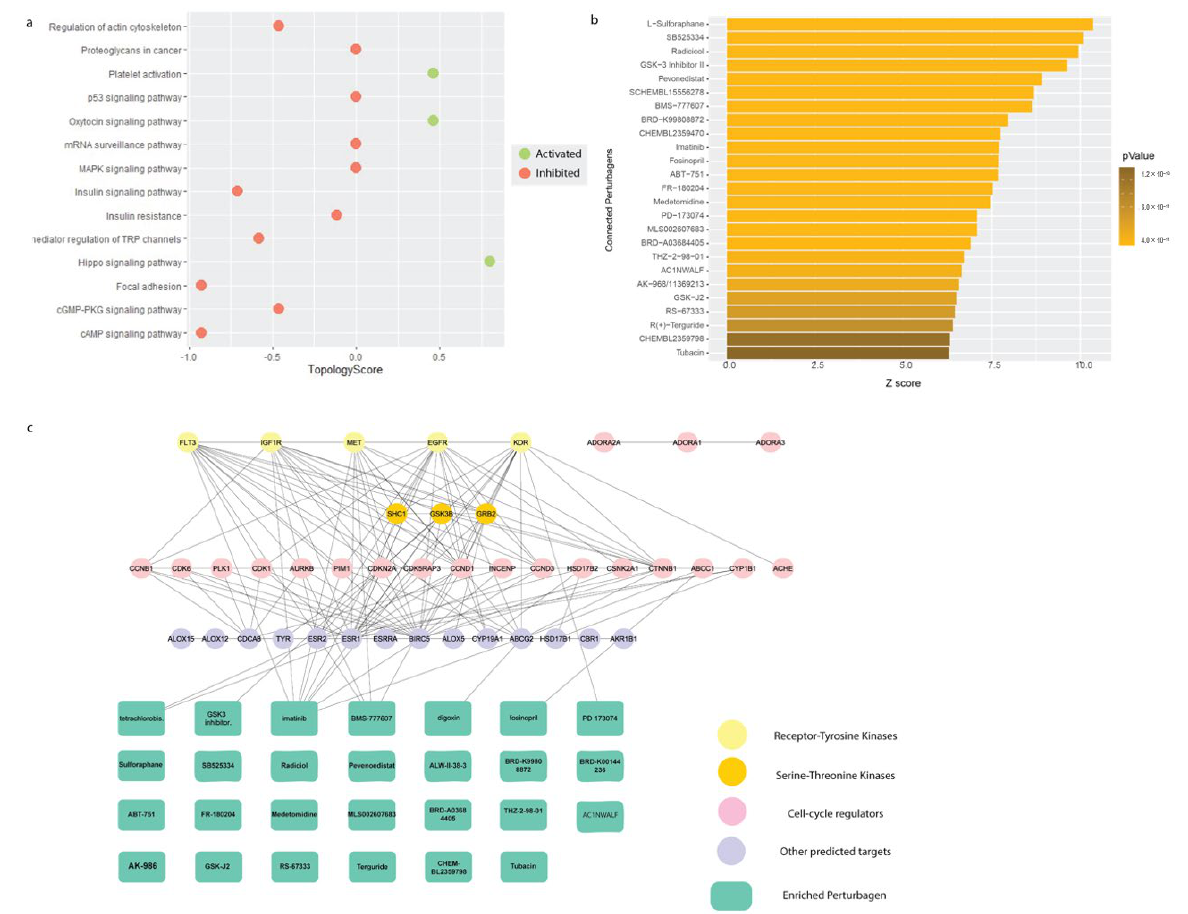
Figure 4. Pathway enrichment and pharmaco-connectivity analysis of the DEP signature. ( a ) Signaling pathway impact analysis (SPIA) of the DEP signature. Green nodes represent pathways that are activated (topology score > 0), and red nodes represent pathways that are inhibited (topology score < 0). ( b ) Significant positively connected perturbagens to the DEP signature, ranked by lowest p -value and highest Z-score. ( c ) Pharmaco-connectivity analysis between the positively connected perturbagens and the predicted targets of Galangin based on structural similarity.